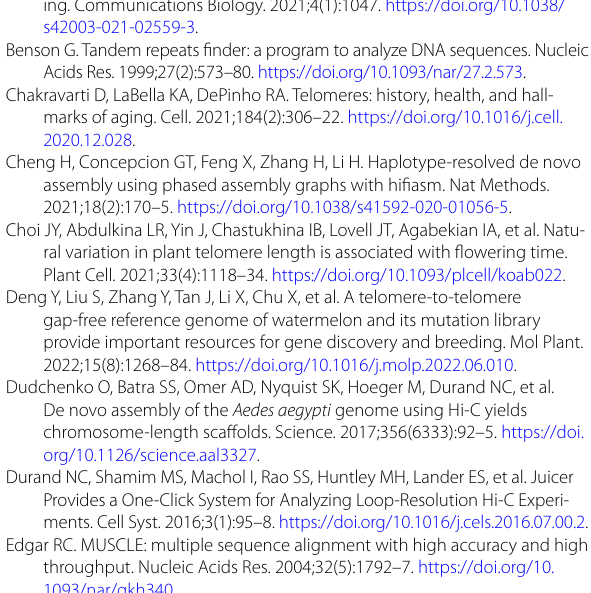
Supplementary Table 3. Comparison of repetitive elements between MDHAPA and MDHAPB. Supplementary Table 4. Statistics of genomic variation releated to new predicted genes between MDHAPs and White. Supplementary Table 5. Mapping rate of Illumina,HIC,HIFI,ONT